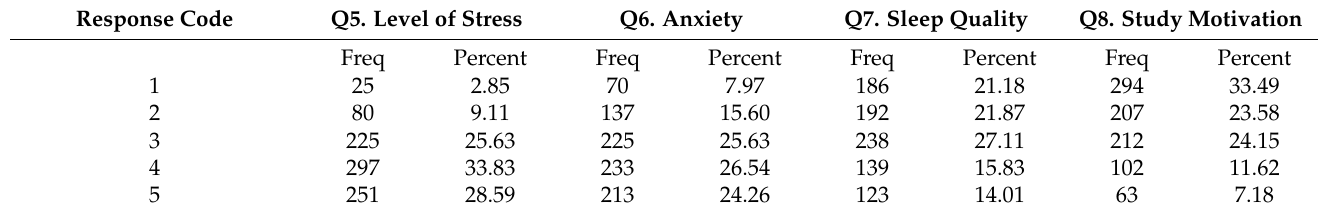
Table 1. Data distribution by responses codes for psychological impact items.